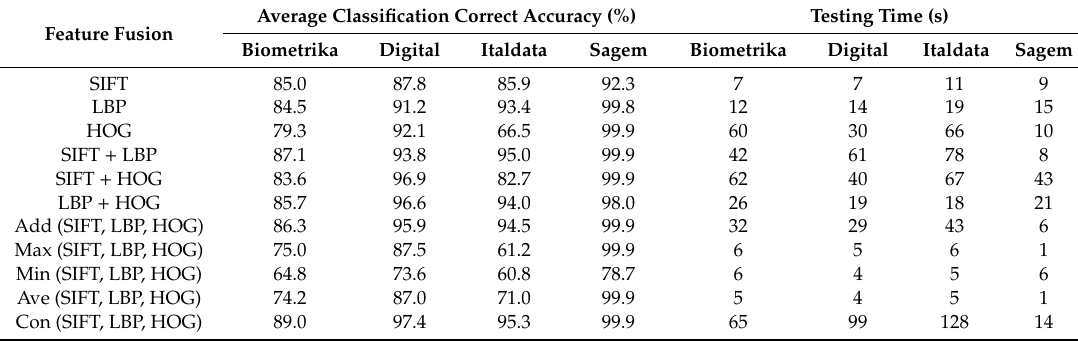
fingerprint set.